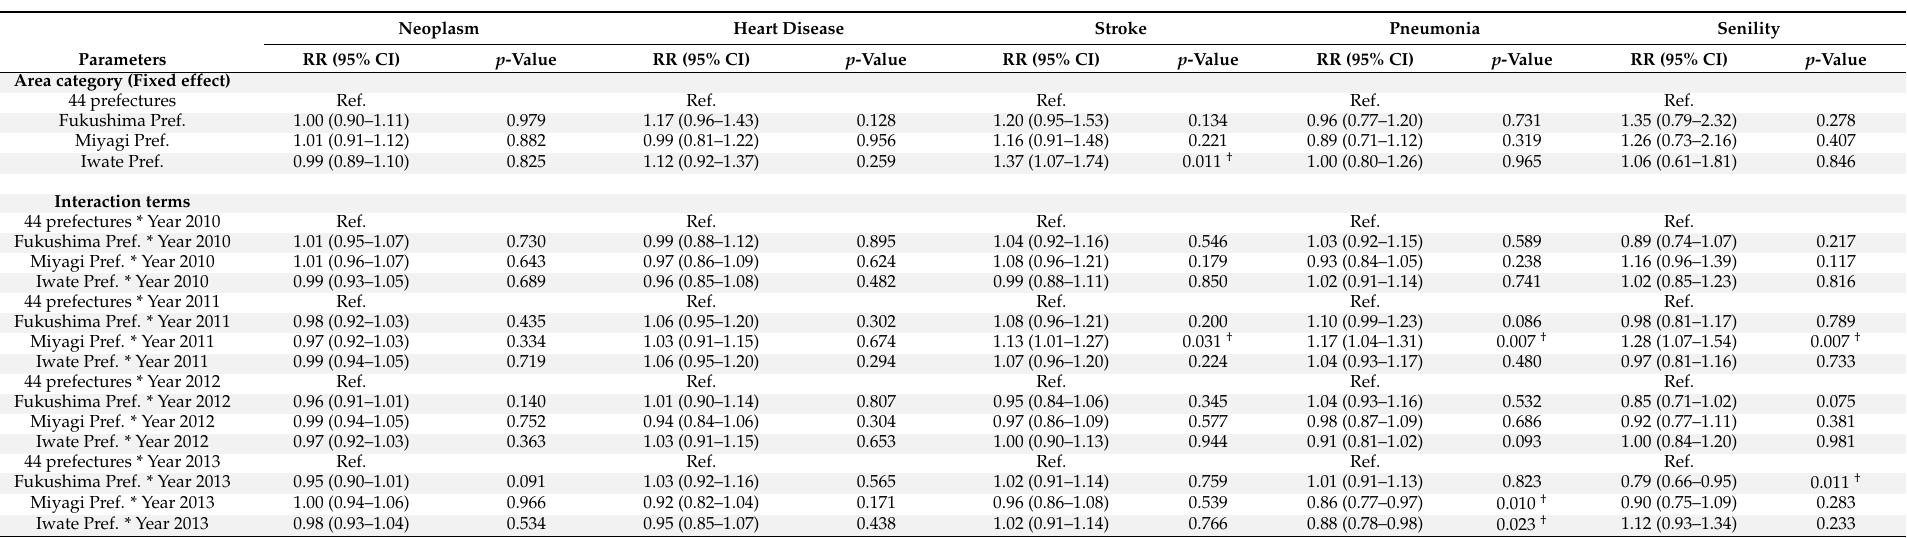
Table 2. Risk ratios and confidence intervals for the fixed effect and interaction terms between the area category and the year of